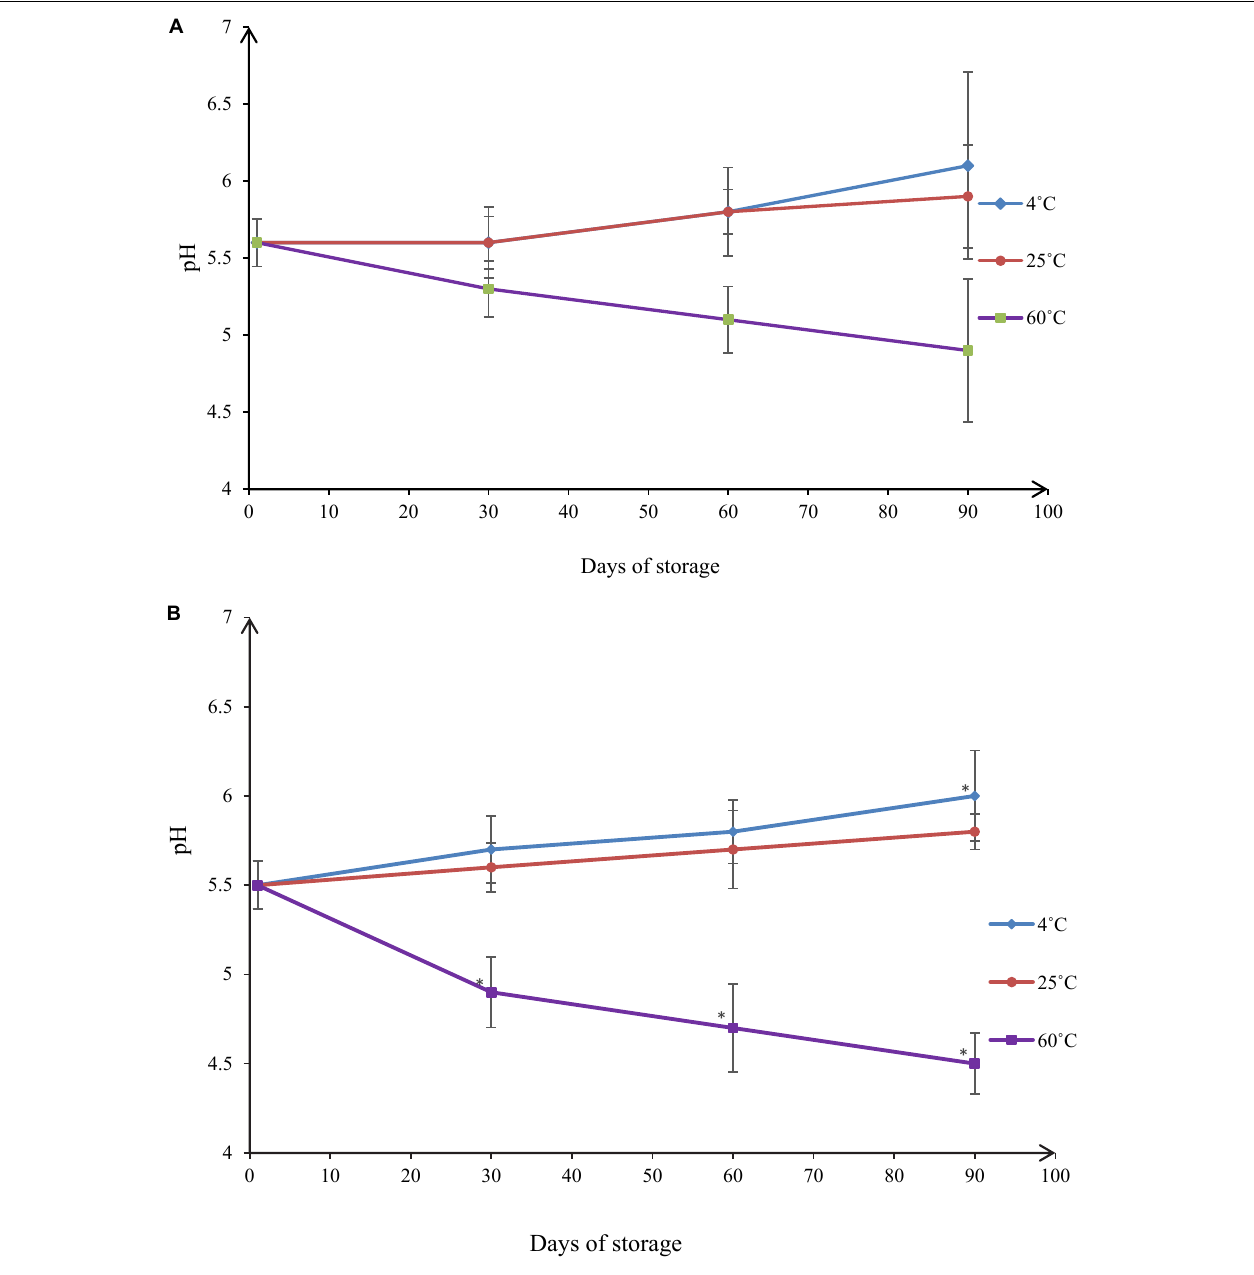
FIGURE 10 | pH values under different storage conditions throughout 90-day stability tests for (A) NT 6 and (B) NT 11 (mean ± SD, n = 3, ∗ p <